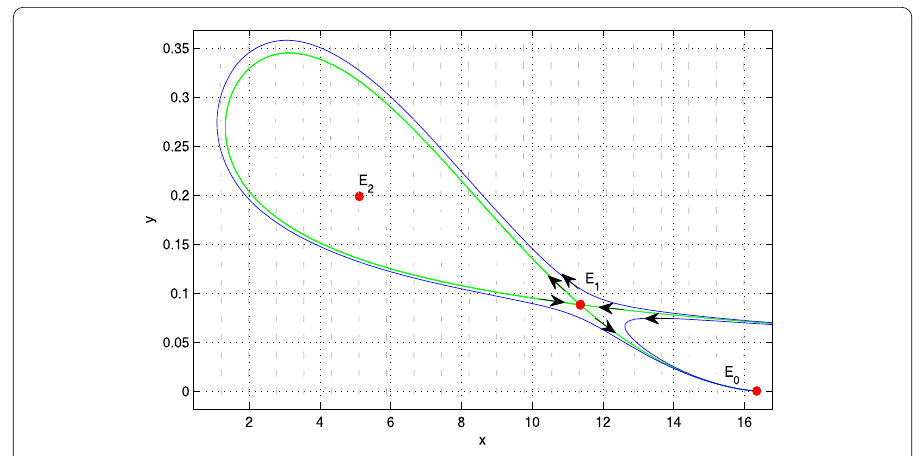
Figure 7 When p = 2, q = 3, A = 15.0804, d = 0.9222, α = 2, γ = 51.2024, equilibrium E 2 is stable and there exists an unstable homoclinic